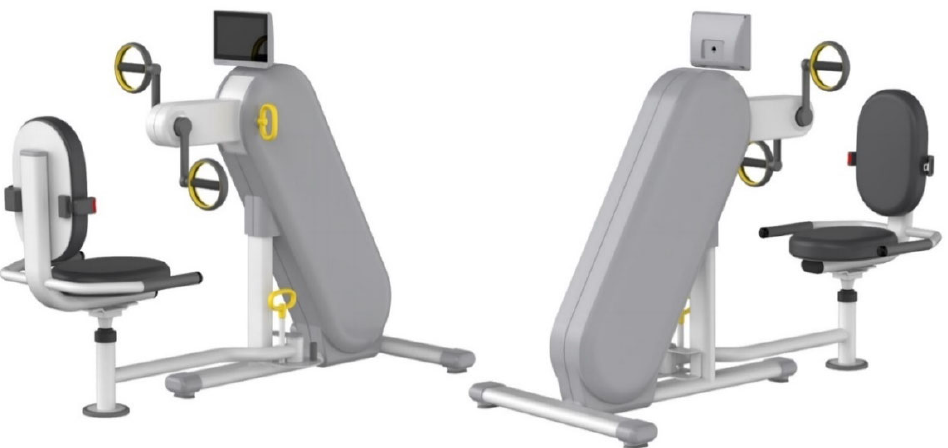
Figure 18. Main features of the arm ergometer .